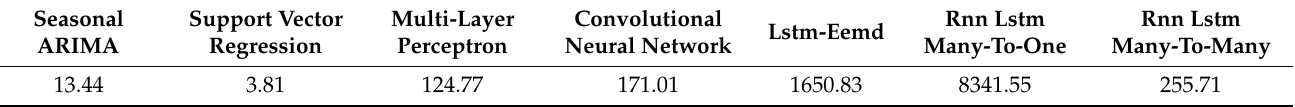
Table 9. Computational